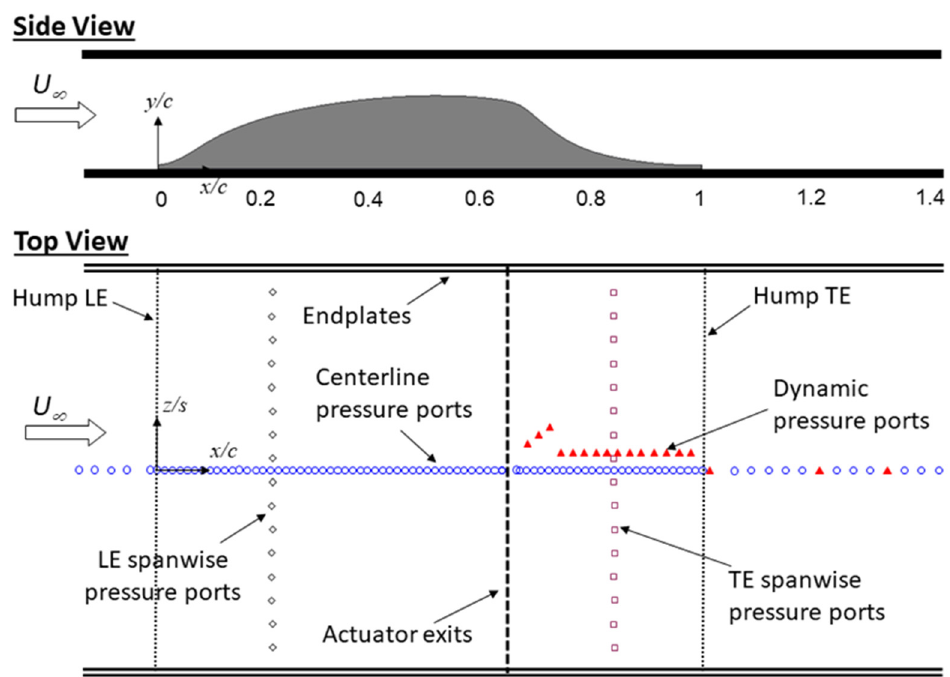
Figure 2. Schematics of the hump model in the wind tunnel. Top view shows surface static and dynamic port locations relative to the hump model.